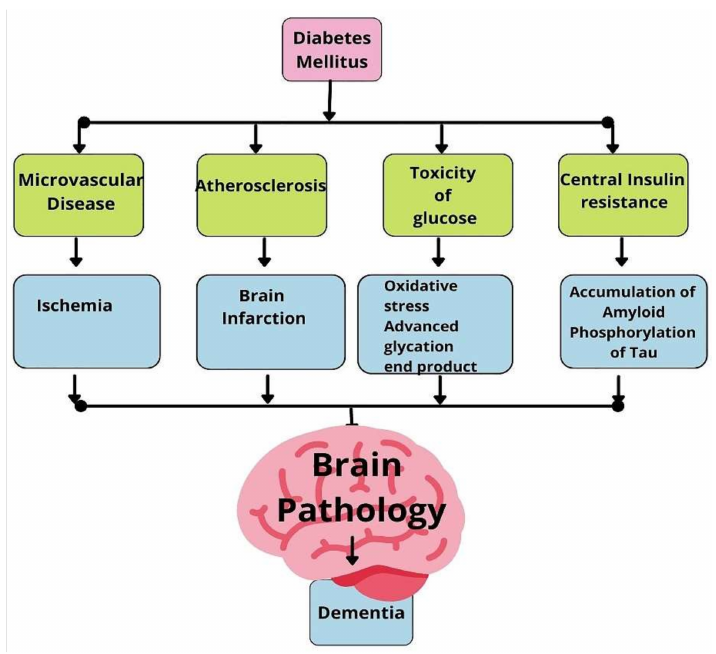
Figure 5. Mechanisms in Diabetes Mellitus which lead to